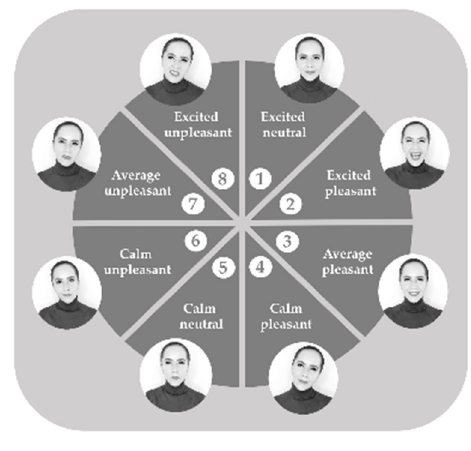
Figure 5. Emocard emotional distribution [28].